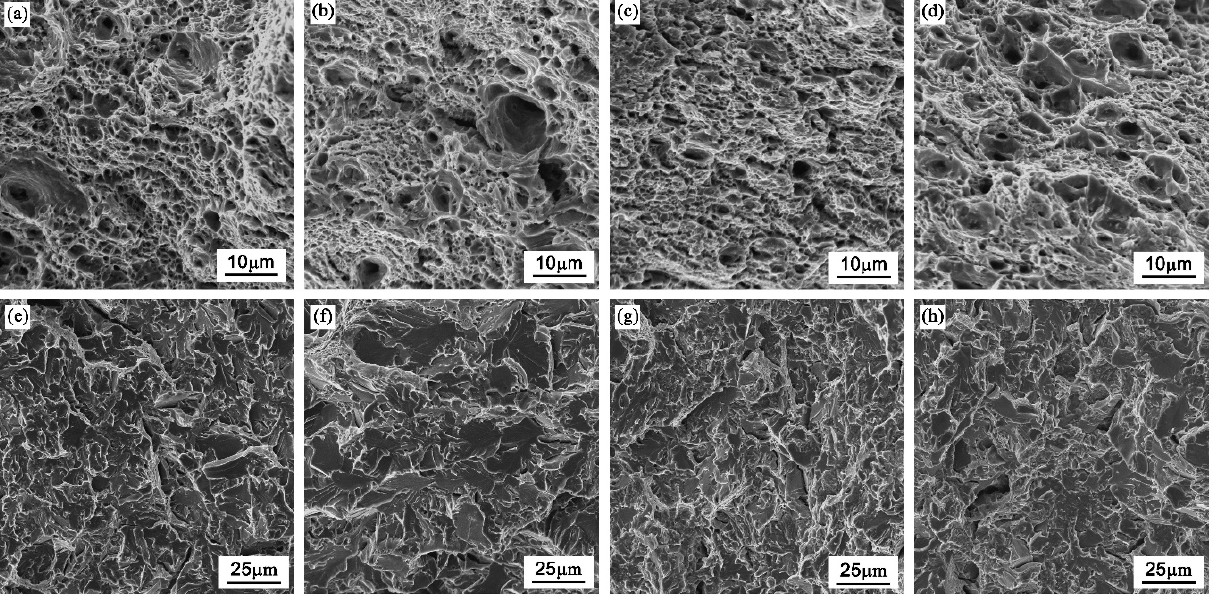
Figure 3. Low magnification fractographs of S1 and S2 samples after Charpy impact at room temperature ( a ) S1 before aging; ( b ) S2 before aging; ( c ) S1 aging 97 h at 580 °C; and ( d ) S2 aging 97 h at 580 °C. Table 2. Proportion of crack-initiated area.